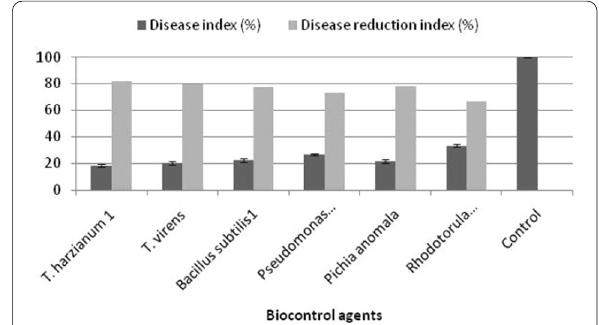
Fig. 3 Effect of bio-control agents on the development of anthracnose on mango fruits after artificial inoculation